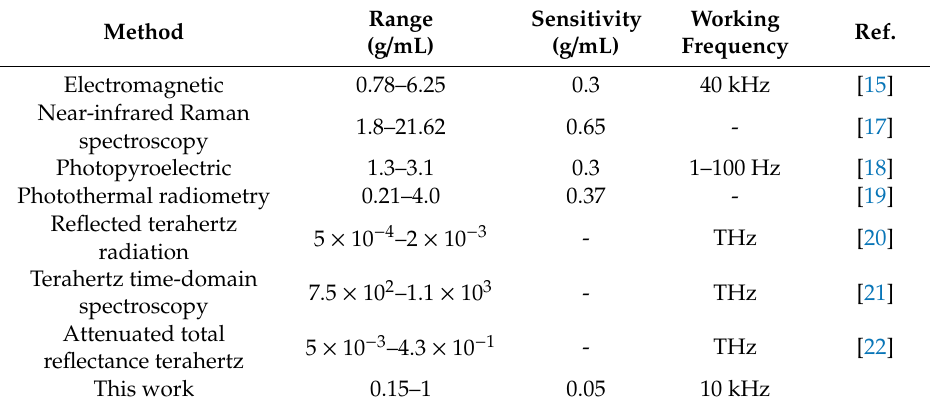
Table 1. Glucose concentration measurement